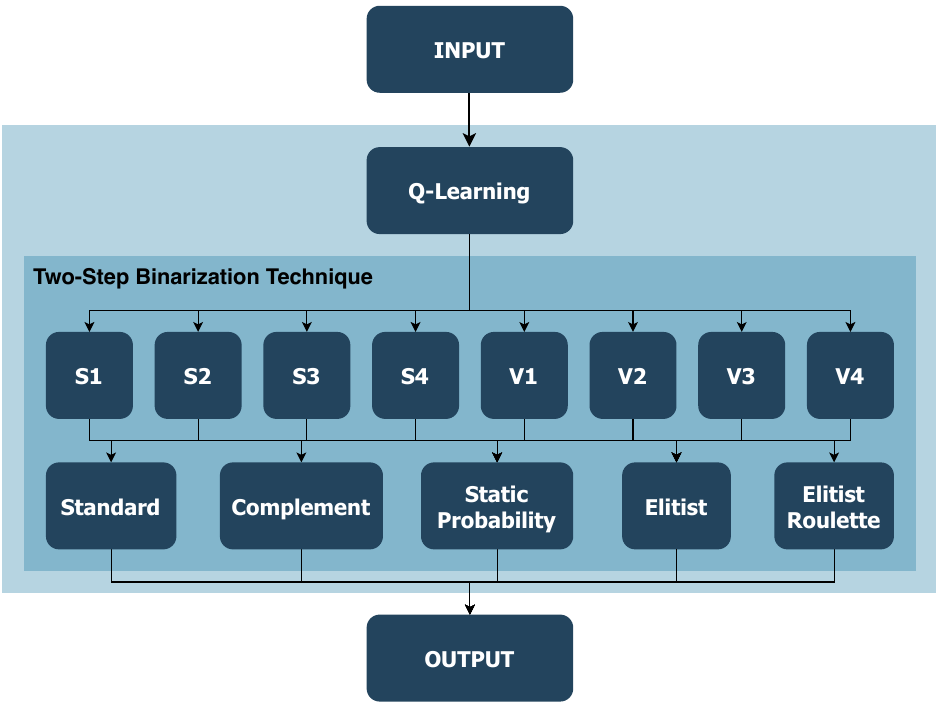
Figure 3. Proposed structure for binarization scheme with